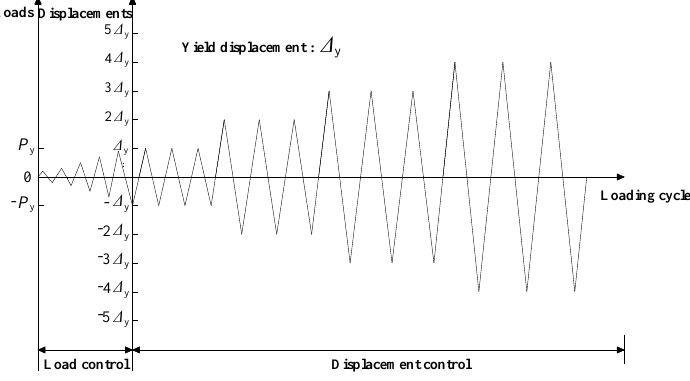
Figure 4. Reversed cyclic lateral loading protocol in the study.